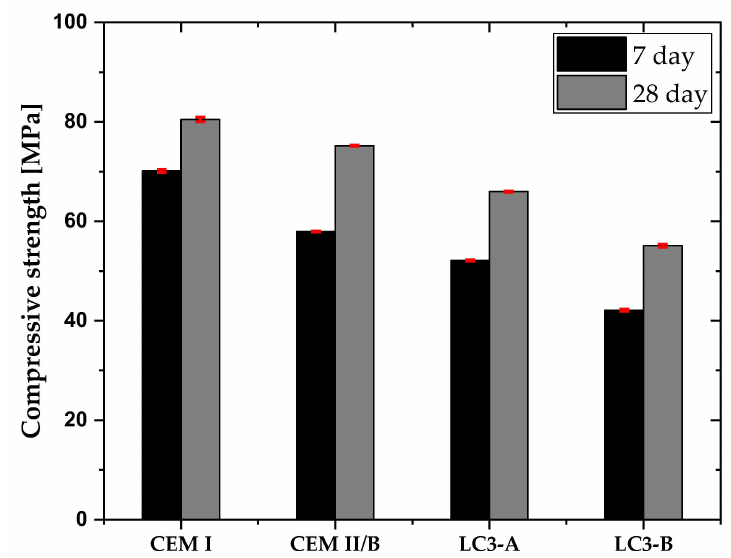
Figure 7. Compressive strength of each